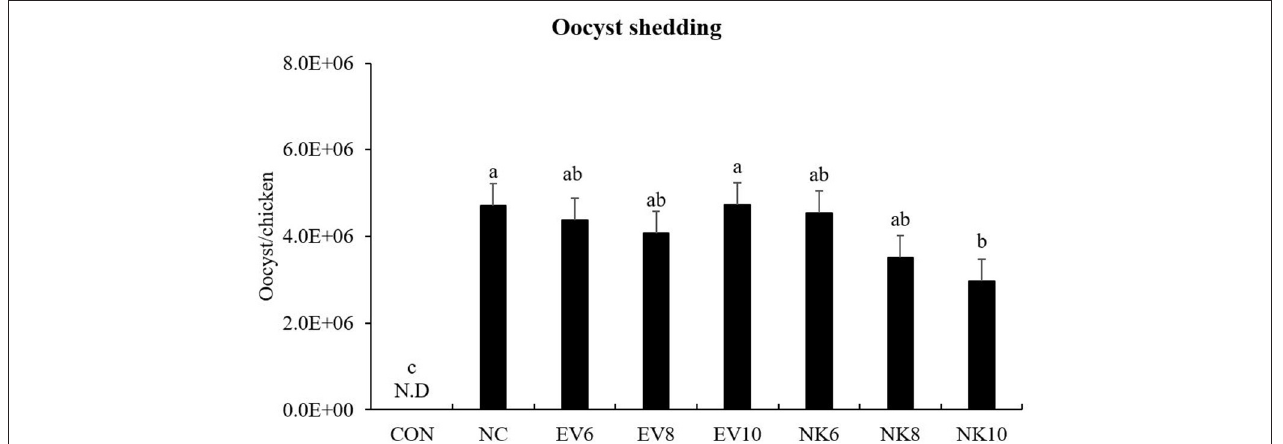
FIGURE 3 | Fecal oocyst counts of Eimeria acervulina -infected chickens fed daily oral treatment with Bacillus subtilis- cNK-2. All chickens except CON were infected by oral gavage at day 15 with 5,000 oocysts/chicken of E. acervulina . B. subtilis were administrated by oral gavage at days 14–16. EV, B. subtilis -EV; NK, B. subtilis- cNK-2; NC, E. acervulina infected non- B. subtilis control; EV6, B. subtilis (empty vector) at 10 6 cfu/day; EV8, B. subtilis- EV at 10 8 cfu/day; EV10, B. subtilis- EV at 10 6 cfu/day; NK6, B. subtilis- cNK-2 at 10 6 cfu/day; NK8, B. subtilis- cNK-2 at 10 8 cfu/day; NK10, B. subtilis- cNK-2 at 10 10 cfu/day. a − c Bars with no common letter differ significantly ( p < 0.05). Each bar represents the mean ± SEM ( n = 8). Fecal samples were collected from 6 to 9 dpi to calculate the oocyst shedding.